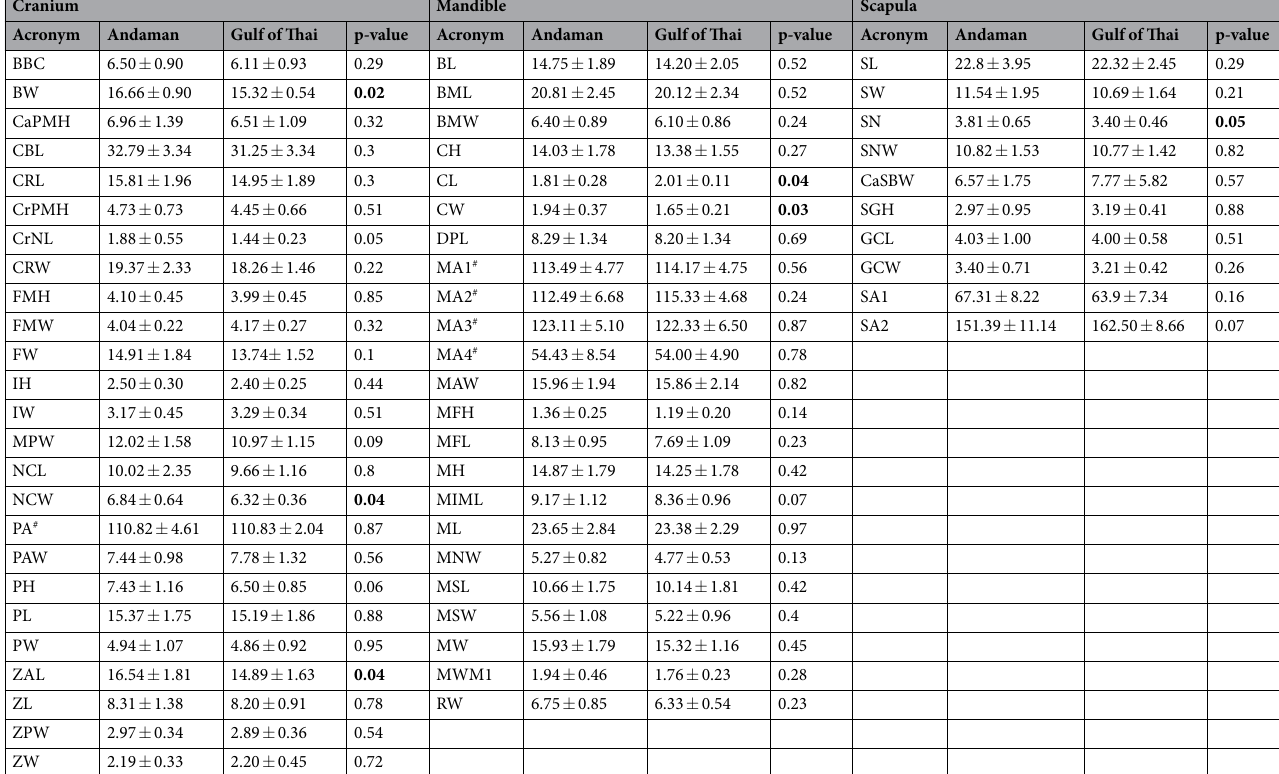
Table 6. Measurement data (mean ± SD) taken from dugong skulls (cranium and mandible) and scapulas from two habitats (the Andaman Sea and the Gulf of Thailand). All parameters are in cm, except superscript # indicates units in